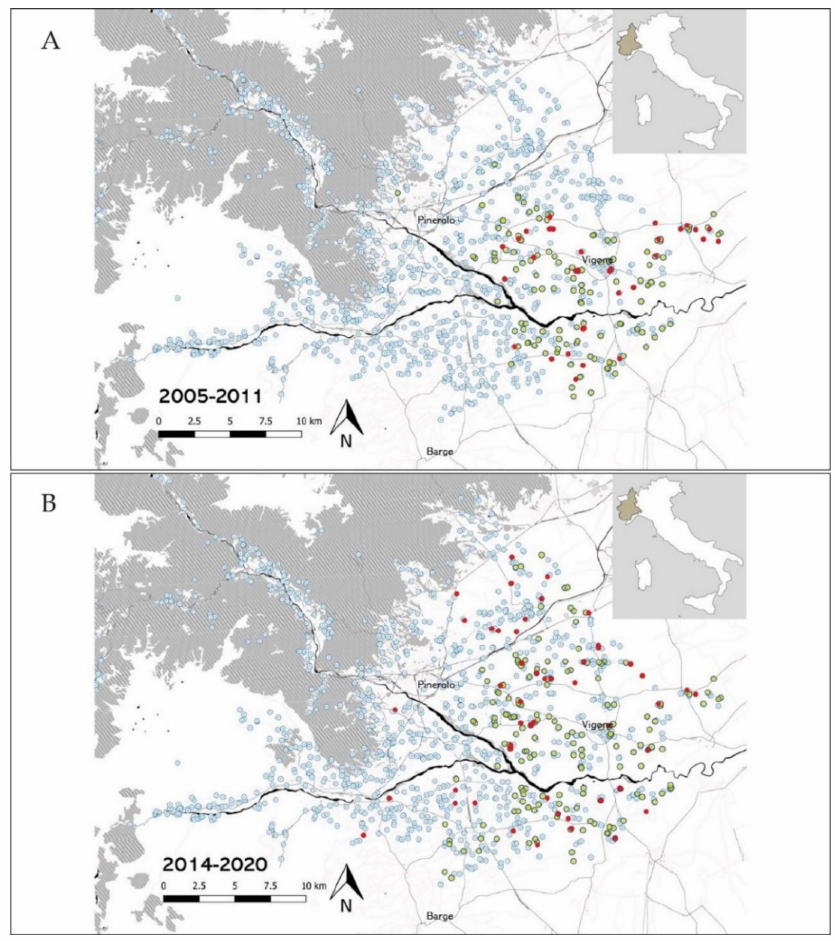
Figure 1. Distribution of case and control farms in the investigated area of Piedmont region. Red dots represent case farms detected between 2005 and 2011 ( A ) and between 2014 and 2020 ( B ), while control farms are represented by yellow dots. Empty light blue dots represent all farms recorded by the BDN in the southern part of the Province of Turin.